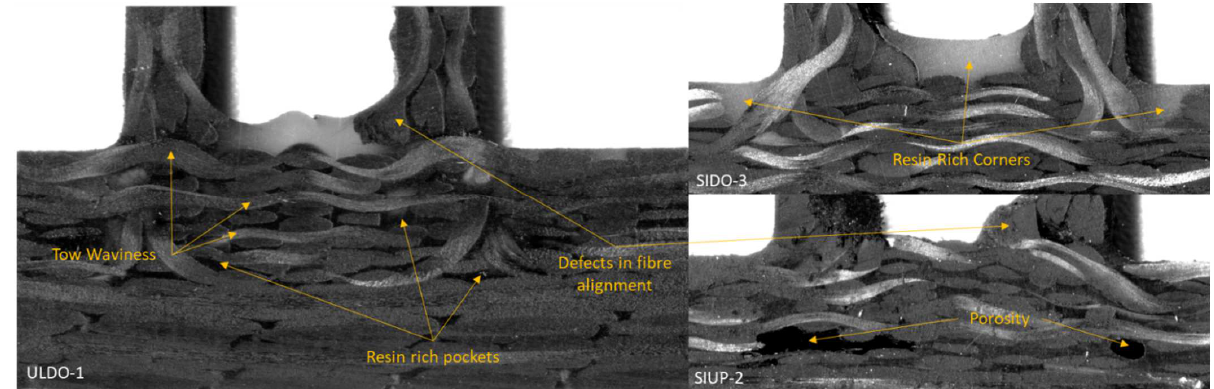
Figure 9. Examples of different defects identified from cross-sectional images. Table 4. Map of defects observed TT on parts from scanned images.